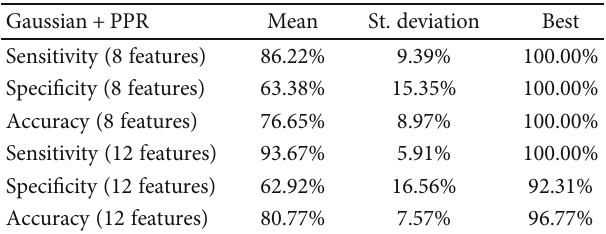
Table 17: Results of SVM with a Gaussian kernel and posterior probability regions.